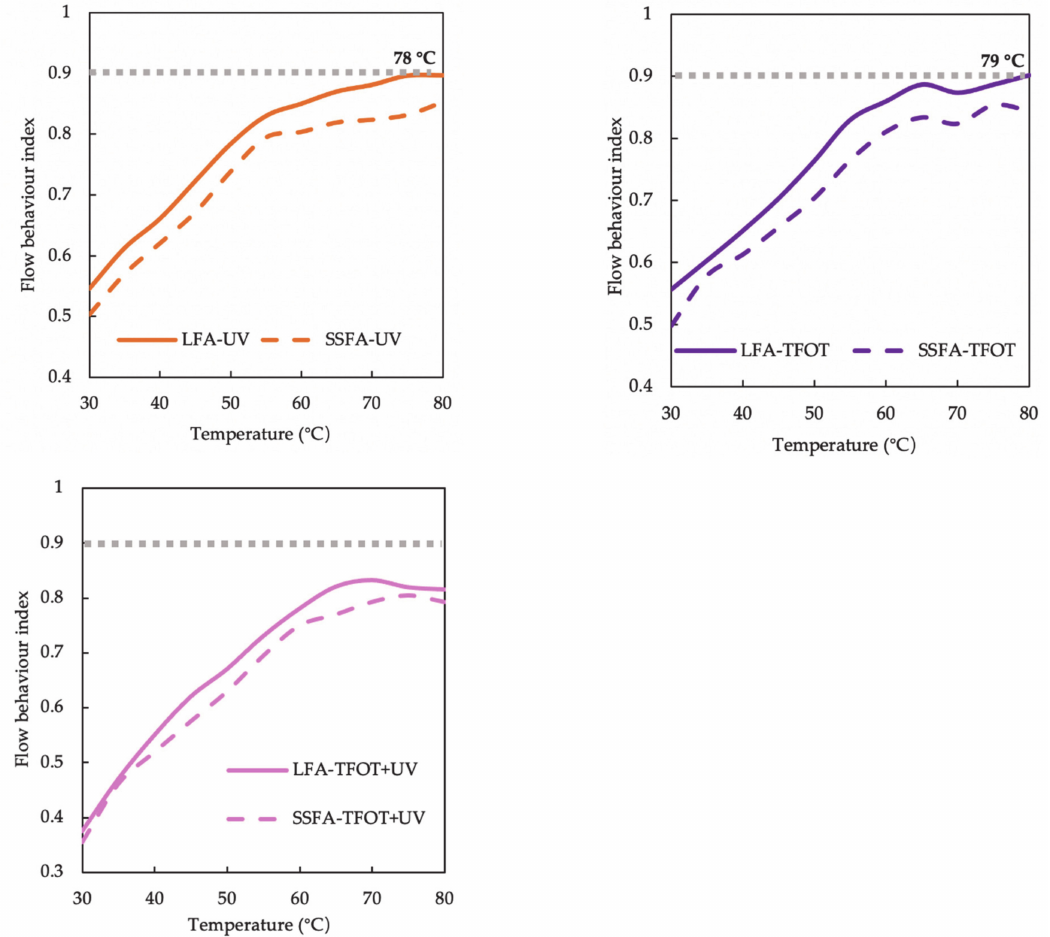
Figure 11. The comparison of SSFA and LFA in self-healing property under various aging